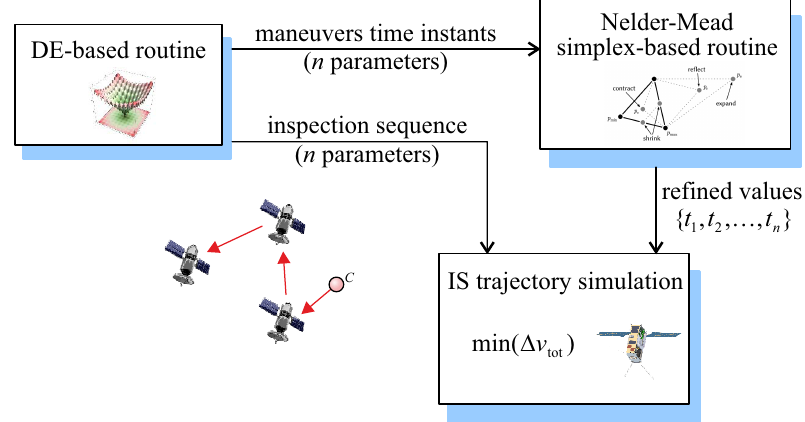
Figure 7. Conceptual sketch of the two-step optimization